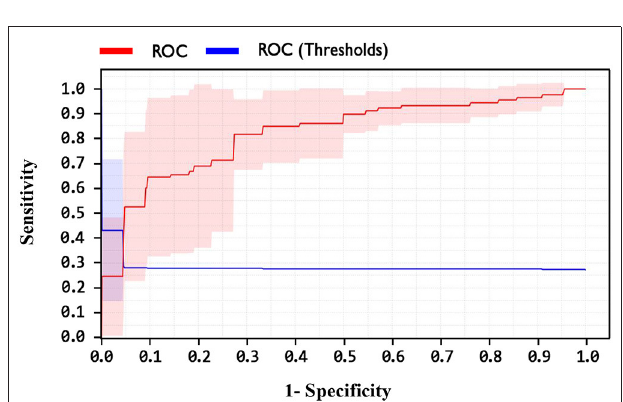
FIGURE 12 | ROC curve for LIBSVM with RBF